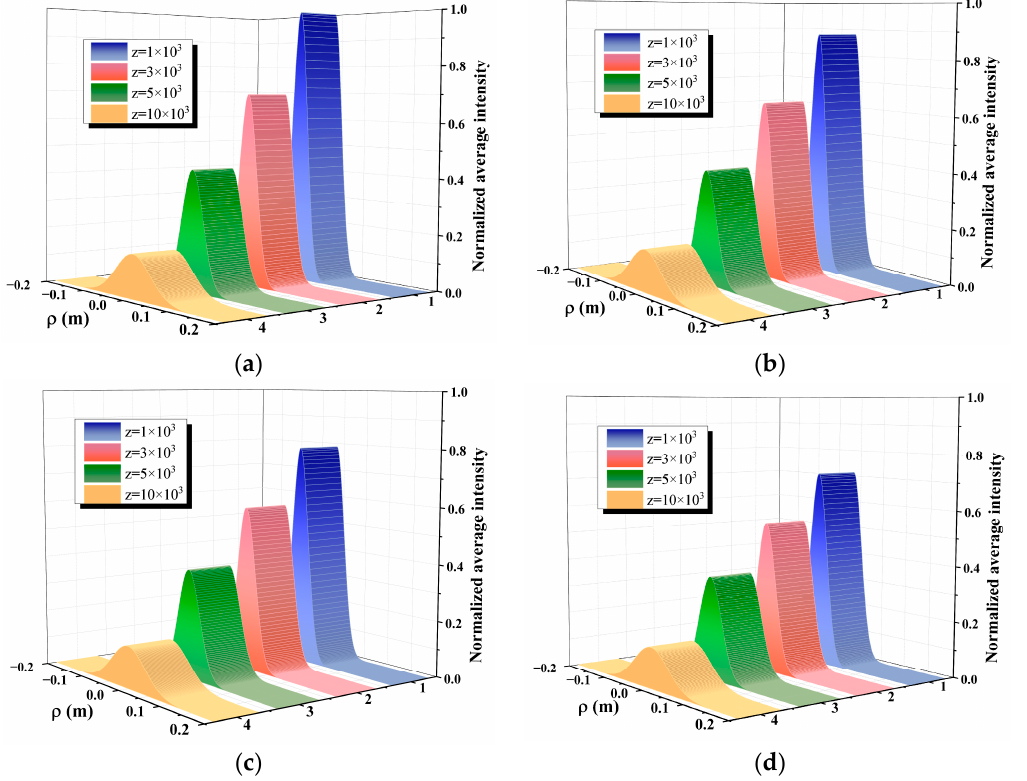
Figure 5. The normalized average light intensity distribution at the receiving plane of completely coherent light and partially coherent light at different transmission distances. The coherence degree (cid:96) is ( a ) 1; ( b ) 3; ( c ) 5; ( d ) 7.